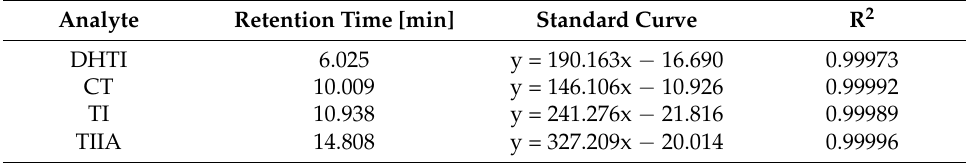
Table 3. Details of UHPLC tanshinone analysis in S. miltiorrhiza